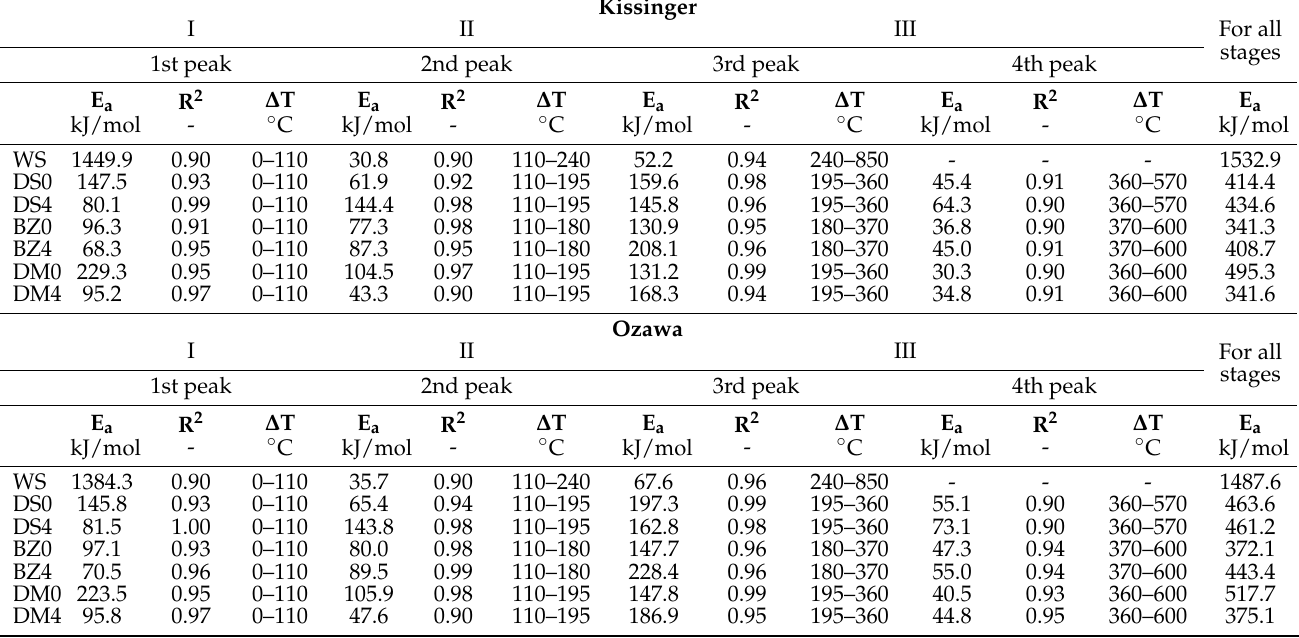
Table 4. Activation energy (E a ) and correlation coefficient (R 2 ) for tested fuels (I—evaporation, II—oxidation mass gain, III—thermal decomposition and burning—Figure